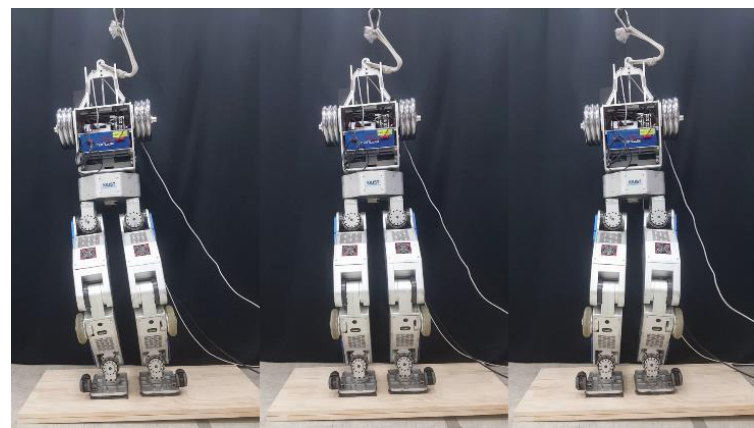
Figure 8. A test of the ZMP controller on an inclined surface. We commanded the CoM trajectory of the robot and measured ZMP data using the proposed and conventional ZMP controllers.